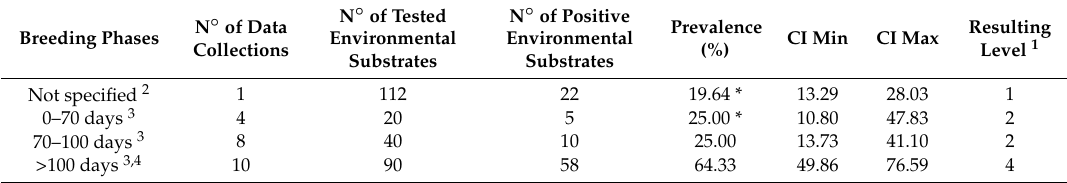
Table 5. Prevalence estimates of MRSA in farming environment substrates, in different farming phases, as estimated by Generalized Estimating Equations on data from the literature review.